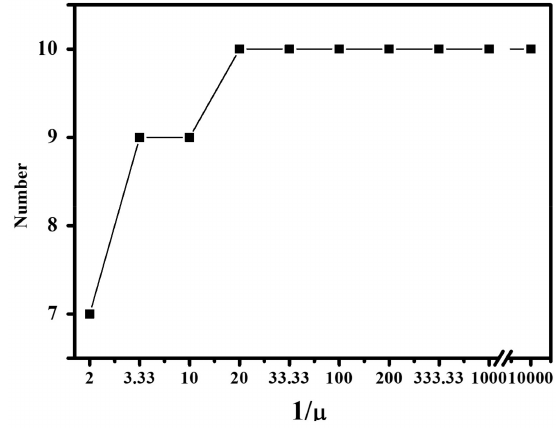
Figure 23. The parameter µ and the number of endmembers.